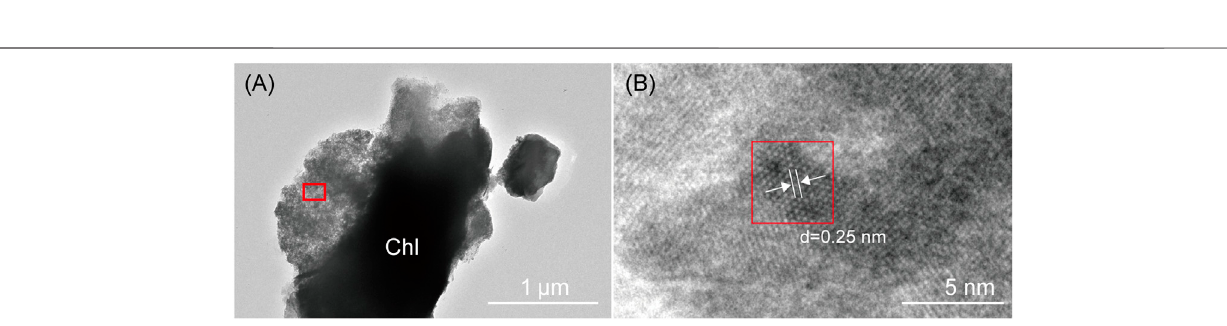
Frontiers in Astronomy and Space Sciences |